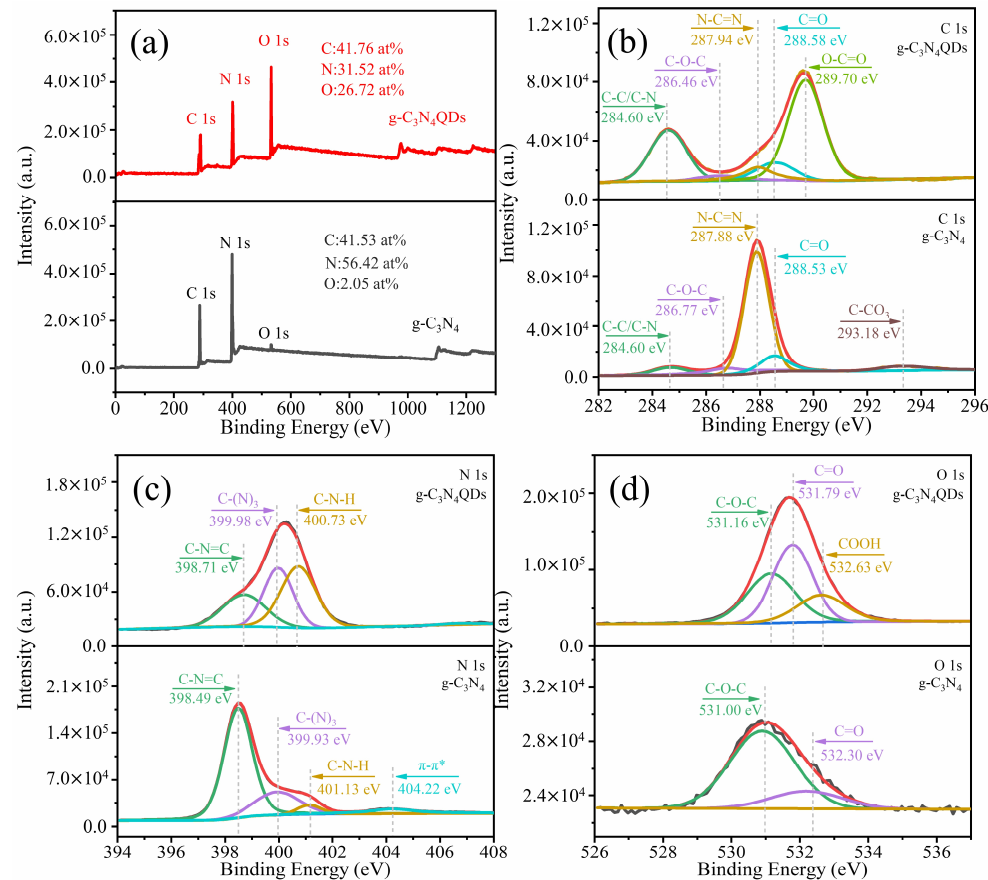
Figure 2. XPS survey spectra ( a ) and the high-resolution XPS spectra of ( b ) C 1s, ( c ) N 1s, and ( d ) O 1s of g-C 3 N 4 and g-C 3 N 4 QDs. 1s of g-C 3 N 4 and g-C 3 N 4